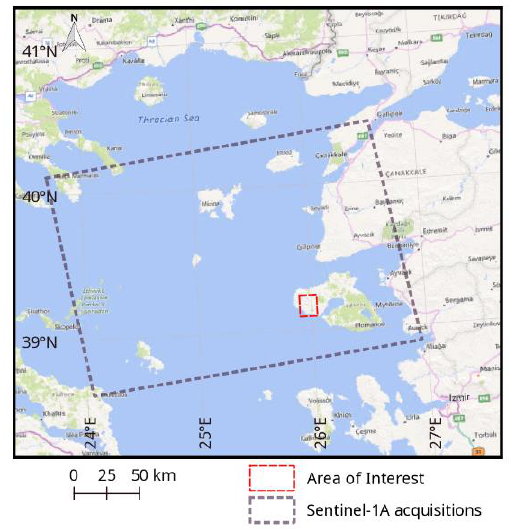
Figure 1. Location map and spatial coverage of Sentinel- 1A dataset. © Google Earth background map